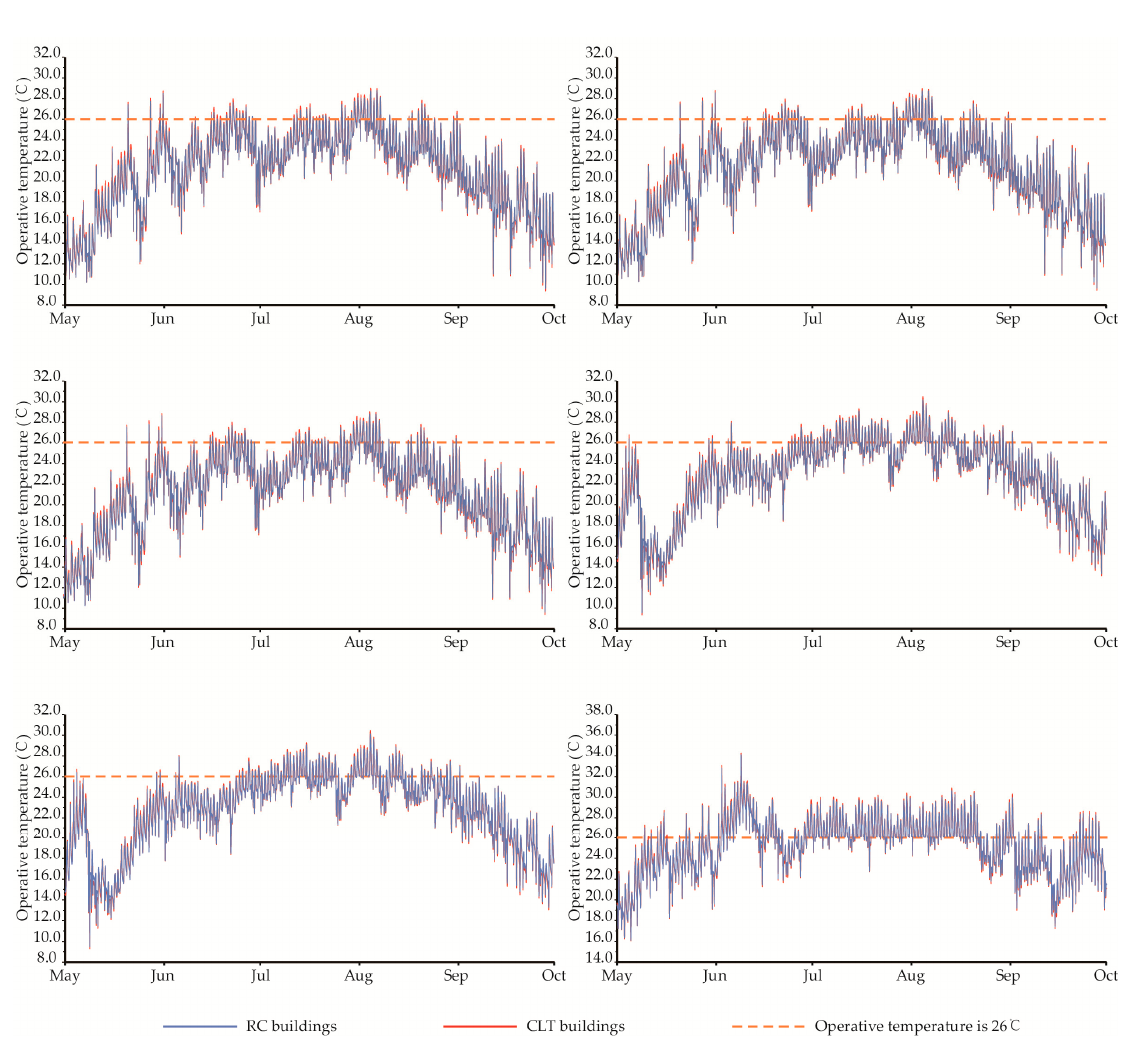
Figure 7. Operative temperature in bedroom 1 on the 11th floor in the RC and CLT building. (Data source: drawn by the